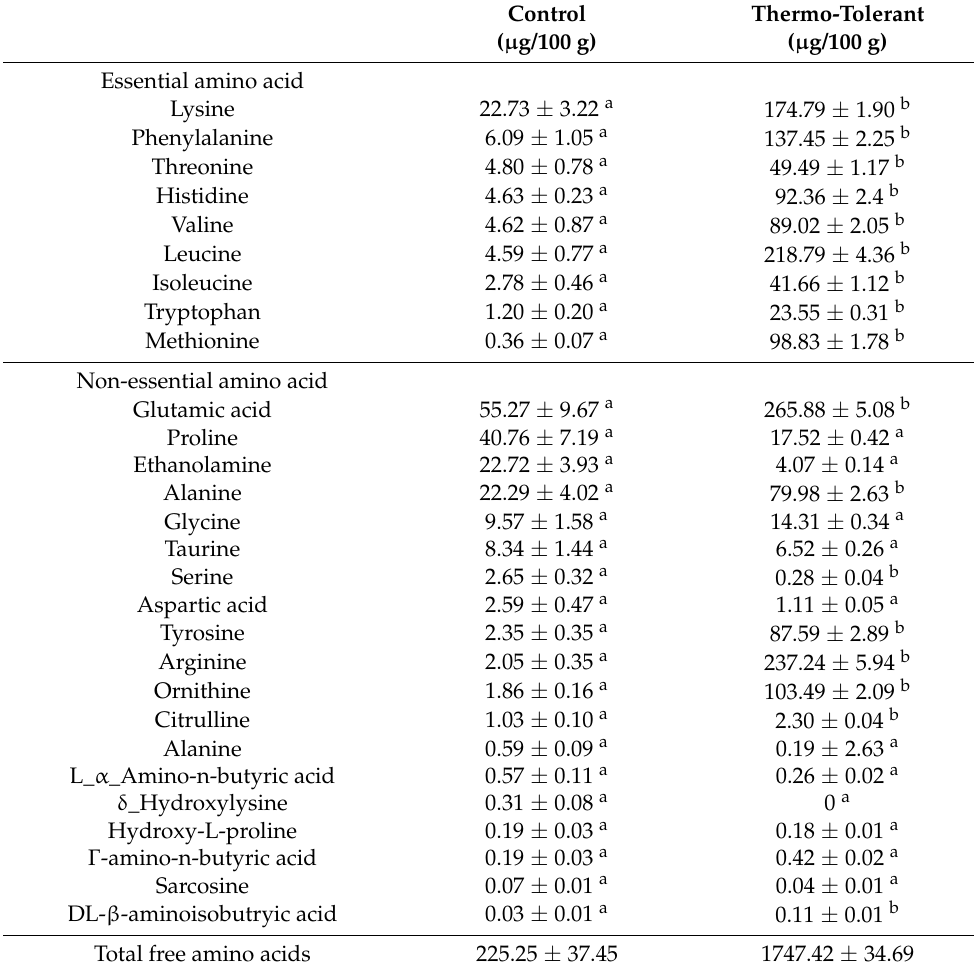
Table 1. FAA profile of inoculated milk made from the control and thermo-tolerant strain of L. bulgar- icus using LC-MS. Data are presented as means ± SD, from the highest to the lowest quantity. Letters a and b indicate statistical difference ( p < 0.001) across each row.